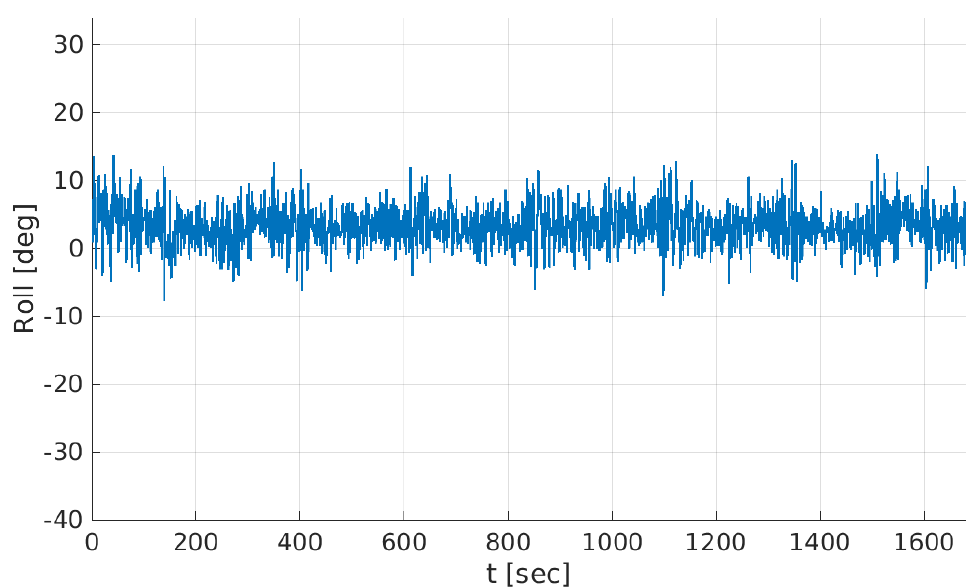
Figure 30. Vehicle’s rollangle during the mission, employing the ALICE